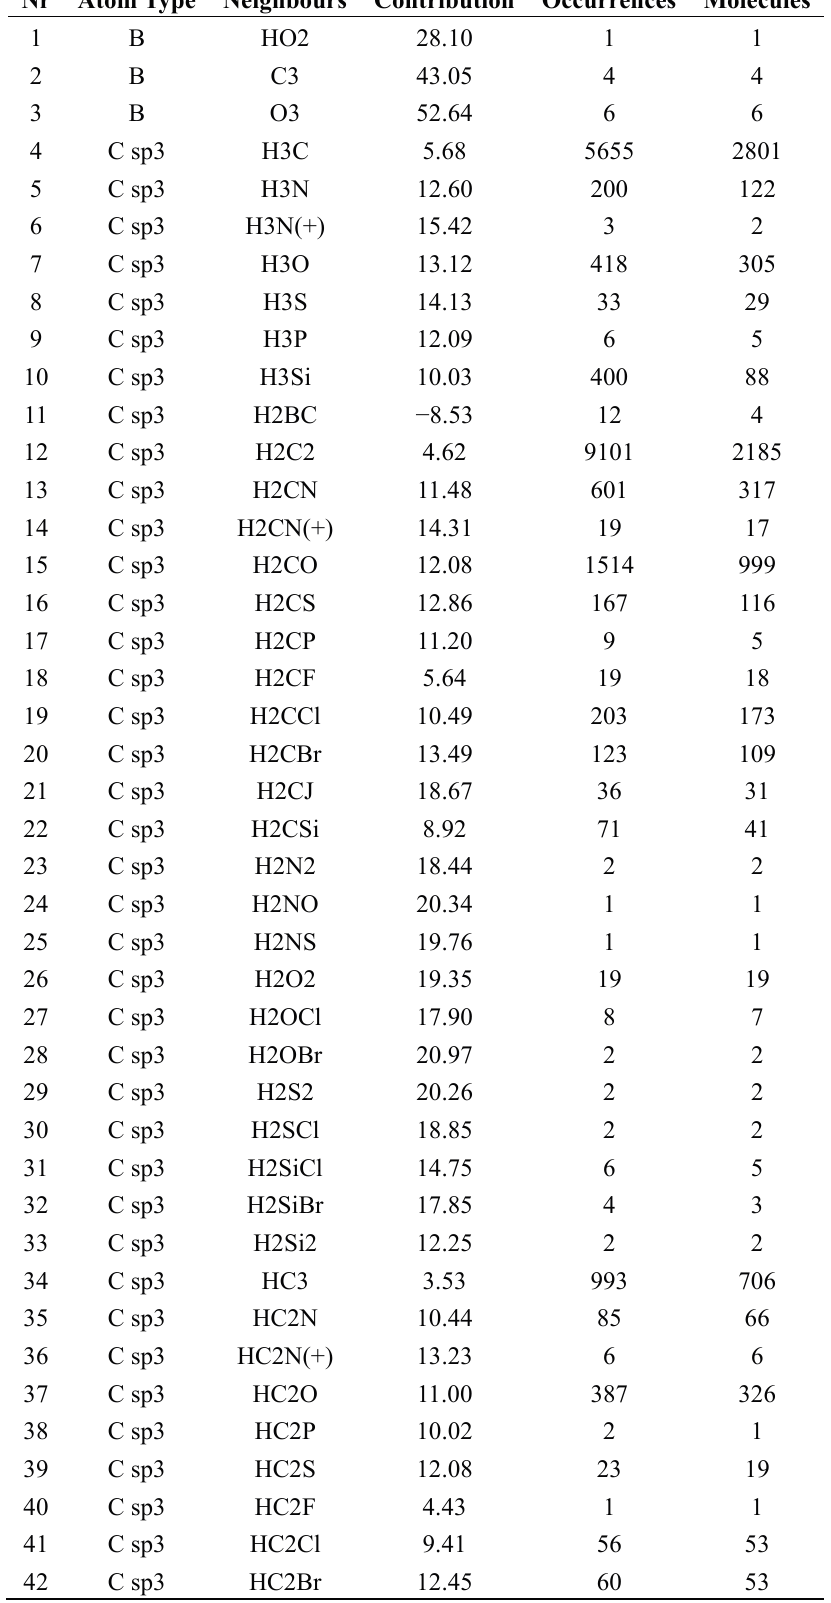
Table 13. Atom group Contributions for Refractivity